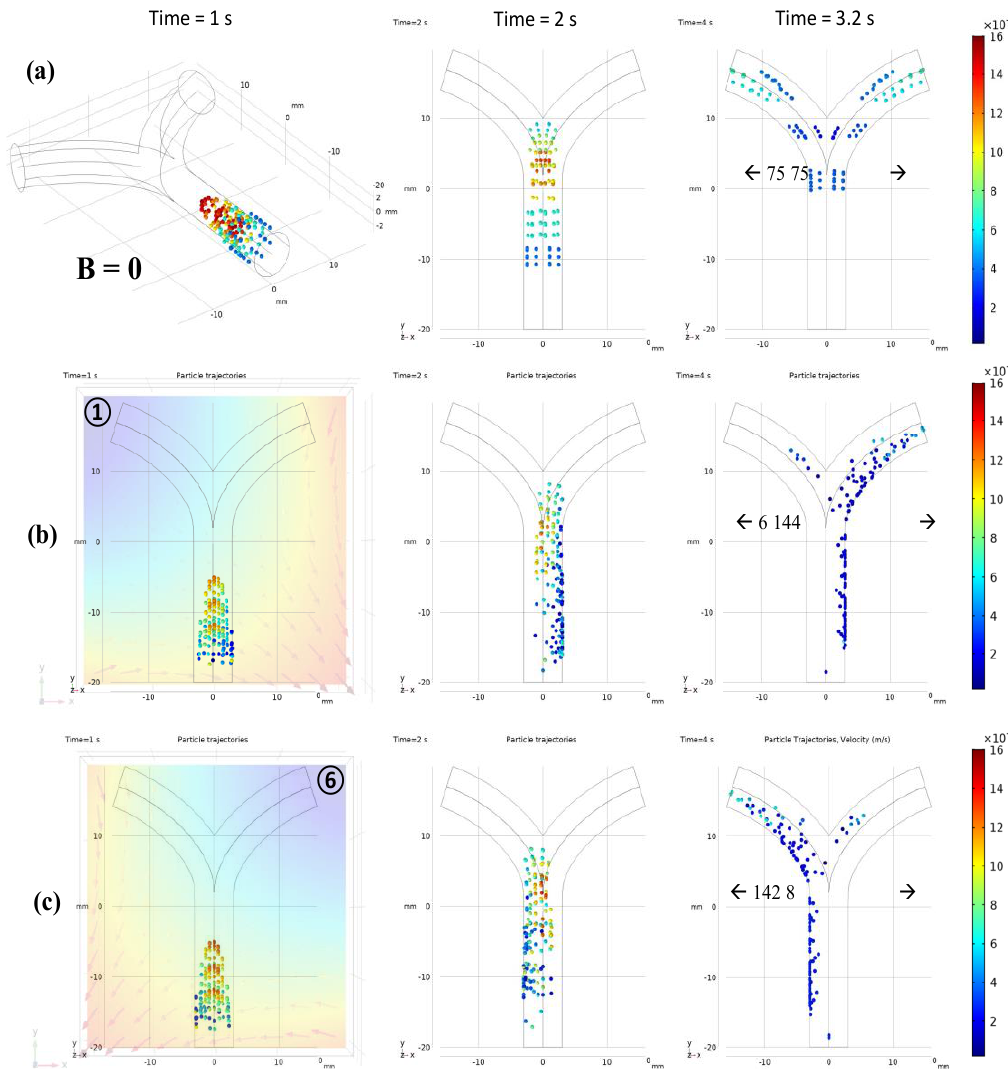
Figure 7. ( a ) Microrobot trajectories under the influence of 𝛻𝐵 in 3D blood vessel. ( a ) B = 0: microrobots are uniformly distributed on left and right bifurcation, each with 50% probability. ( b ) FFP positioned at top left corner, ① : 𝛻𝐵 𝑥 forces microrobots toward right bifurcation and 𝛻𝐵 𝑦 decelerates microrobots, allowing them to linger with 𝛻𝐵 𝑥 . ( c ) FFP positioned at top right corner, ⑥ : 𝛻𝐵 𝑥 forces microrobots toward left bifurcation and 𝛻𝐵 𝑦 decelerates microrobots, allowing them to linger with 𝛻𝐵 𝑥 .